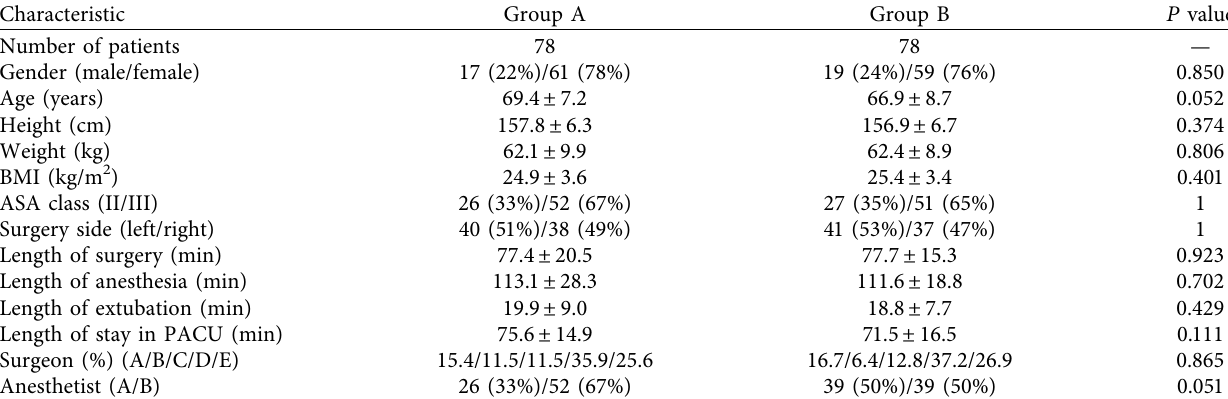
Table 1: Demographic and perioperative data.